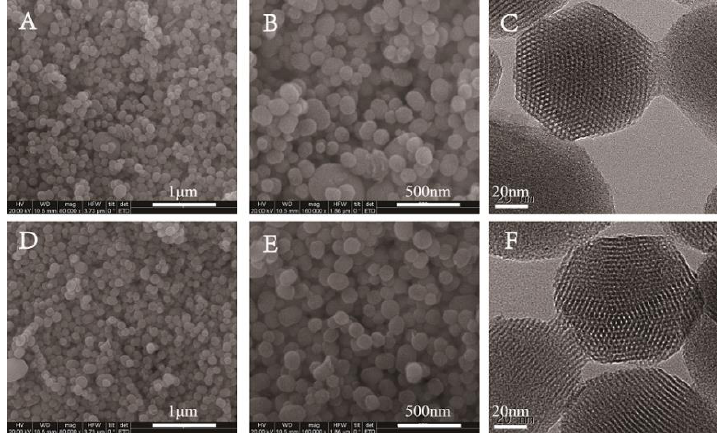
Figure 3. Scanning electron microscopy (SEM) ( A , B , D , E ) and transmission electron microscopy (TEM) ( C , F ) images of nanoparticles. Pristine MSN (P-MSN) ( A , B , C ); sulfonate-functionalized MSNs (MSN-SO 3 ) ( D , E , F ). Scale bars: ( A , D ) 1.0 μm, ( B , E ) 500 nm, and ( C , F ) 20 nm.